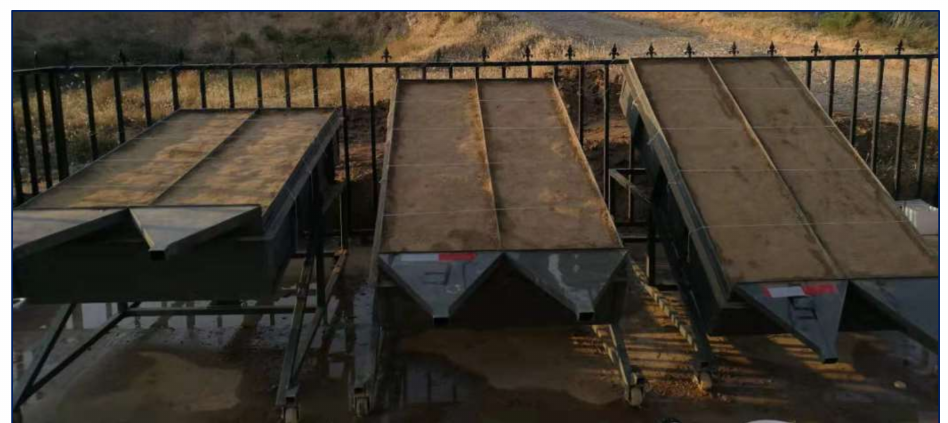
Figure 3. The soil tank used in the